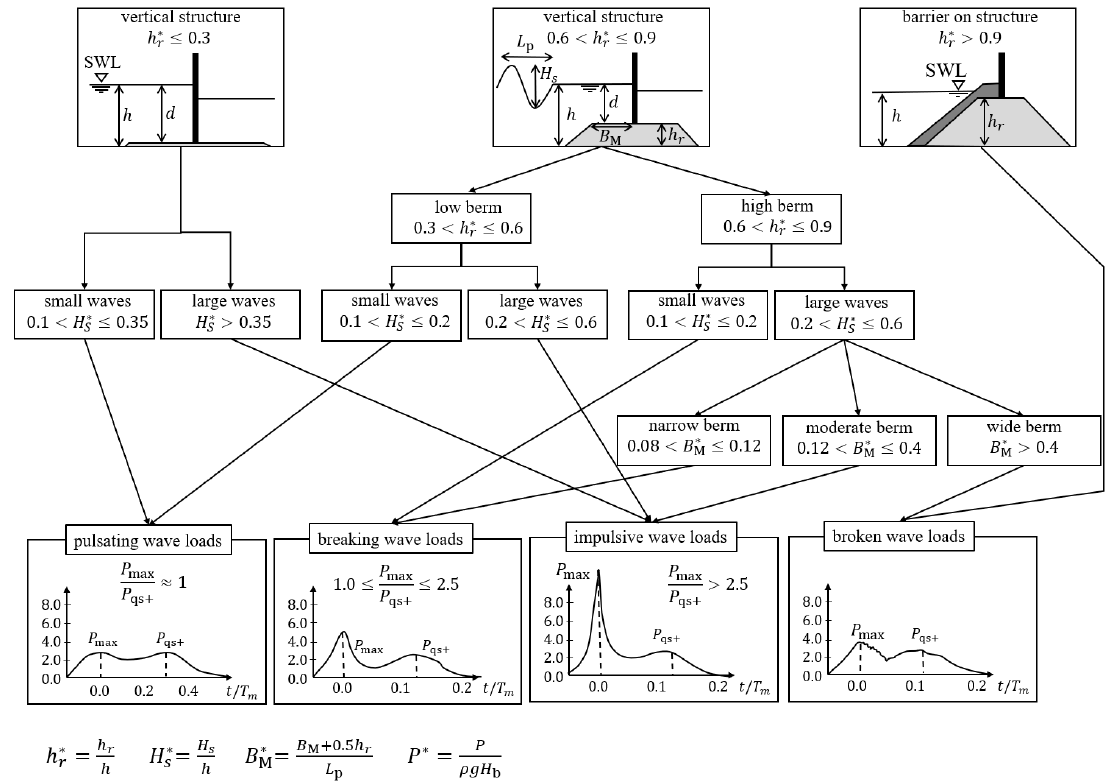
Figure 1. Wave loading classification as proposed by Kortenhaus and Oumeraci [12] and adapted for slender hydraulic structures by TAW [4]. With permission from TAW,